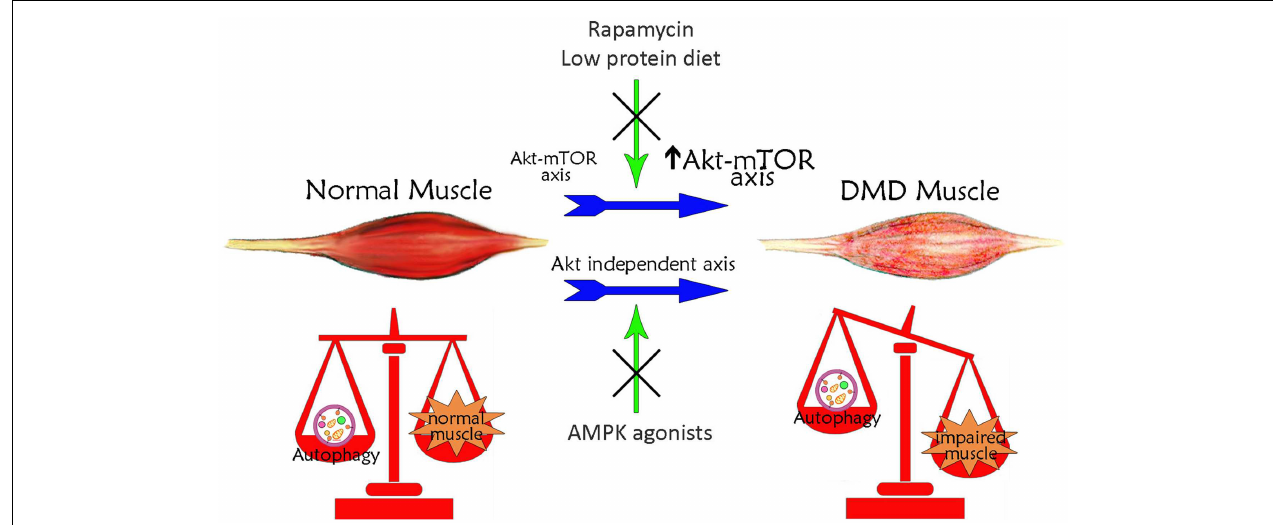
Treatments with rapamycin or low-protein diet, acting on Akt pathway, restore autophagy ameliorating DMD muscle phenotype and function.The impaired autophagy may also occur independently of Akt.Treatments with AMPK agonists, which increase AMPK activation, counteract the Akt-independent axes enhancing autophagy and inducing a positive effect in DMD